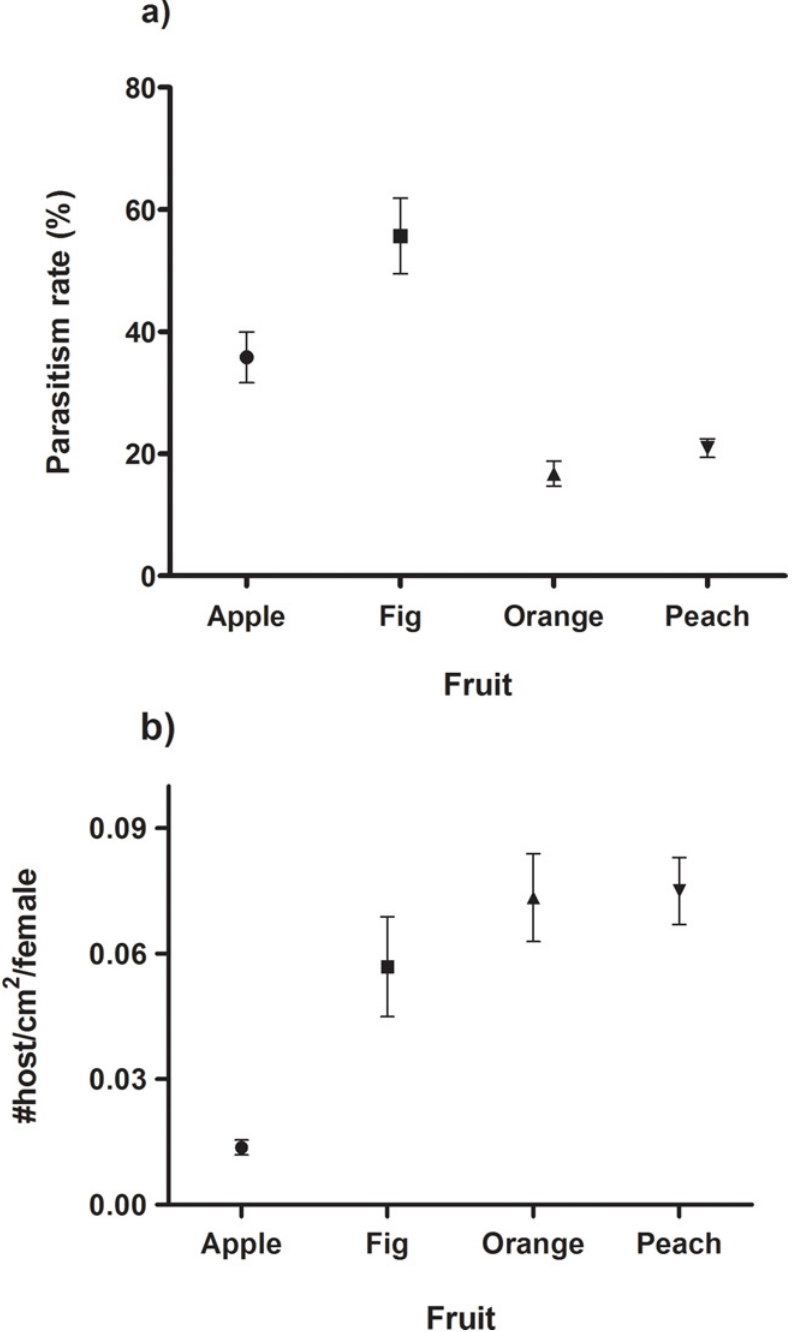
Fig 4. Quality of different fruit species as foraging substrates. a) Mean parasitism rate by Diachasmimorpha longicaudata recorded in different fruit species infested by Ceratitis capitata larvae. b) Mean density of larvae offered during infested fruit exposure in experiment 4. Bars show the standard error of the mean.